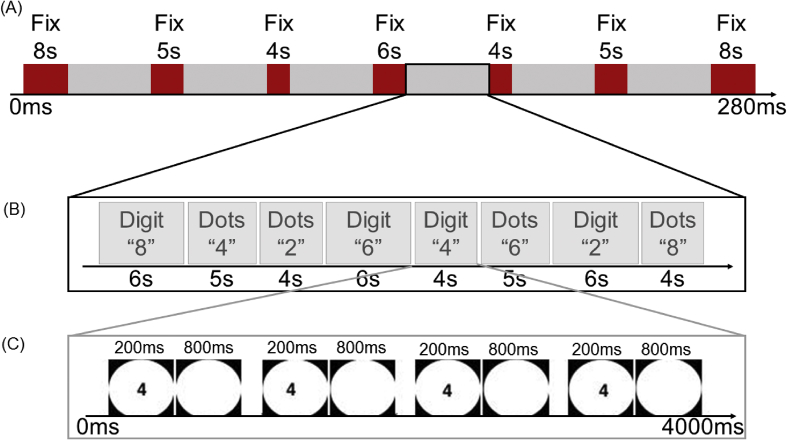
Summary of the experimental design; (a) Example of an experimental run; (b) Example of 8 experimental blocks; (c) Example of 4 trials within one experimental block.